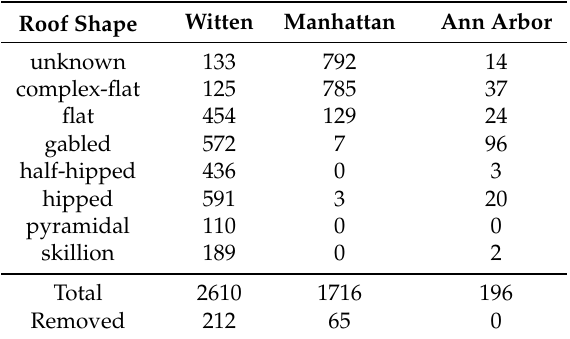
Table 4. Breakdown of roof labels by